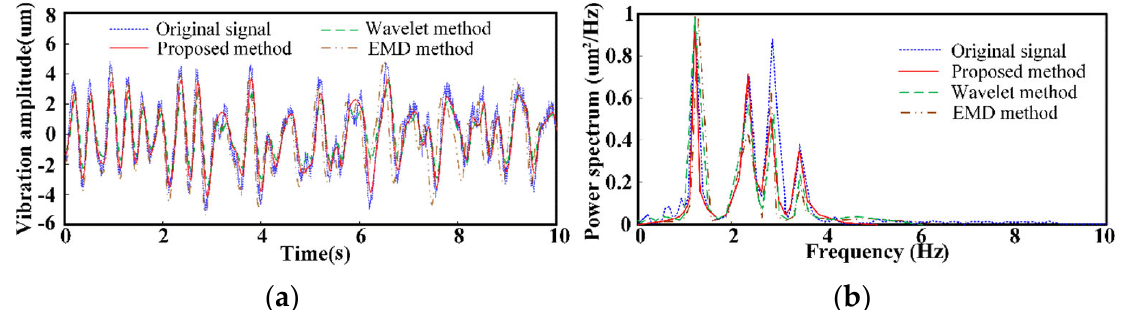
Figure 9. Comparison of calculation results of three noise reduction methods. ( a ) Time history sig ‐ nals; ( b ) Normalized power spectra.